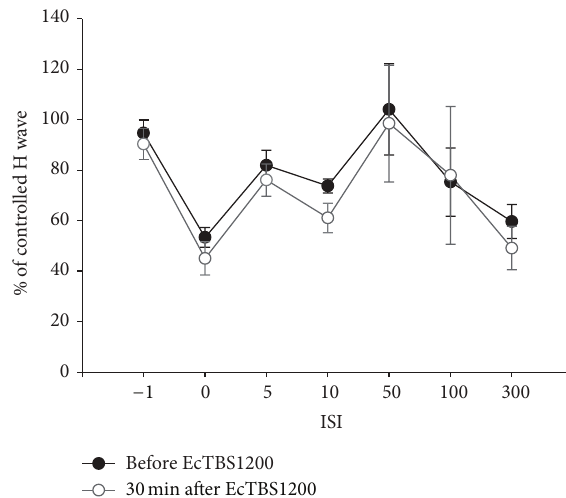
Figure 3: No change in RI before and after EcTBS. The amplitude of the H-reflex was inhibited by radial-medial stimulation at ISI of 0, 10, 100, and 300 ms. EcTBS1200 did not alter the curve of RI.